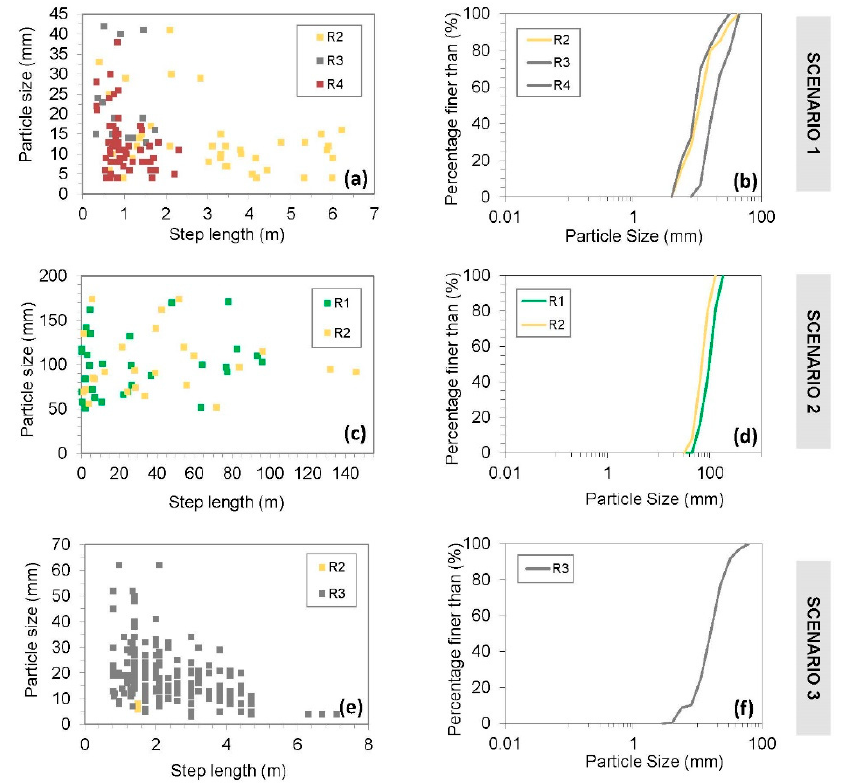
Figure 10. Mobility of tracer stones in the study reaches: step-length and GSD of mobilised particles: ( a , b ) Scenario 1 (Small magnitude flood plus hydropeaking); ( c , d ) Scenario 2 (High magnitude flood and hydropeaking); and ( e , f ) Scenario 3 (Single hydropeak, see Section 3.2 for details).